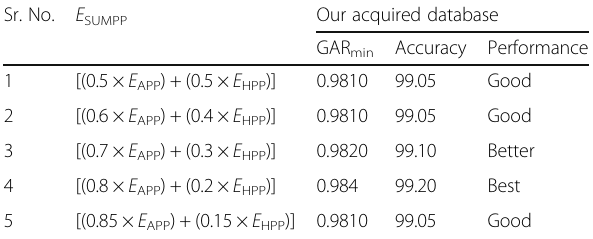
Table 3 Results obtained for different combinations of weights Sr. No. E